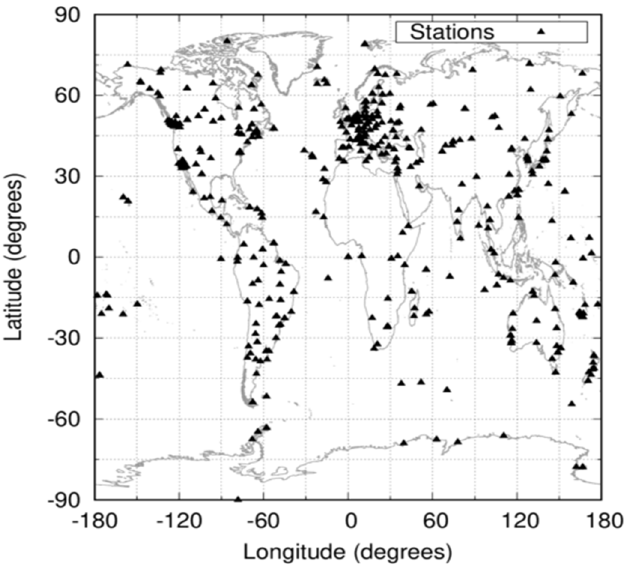
Figure 1. Distribution of permanent stations from the IGS MGEX network used in the present study.